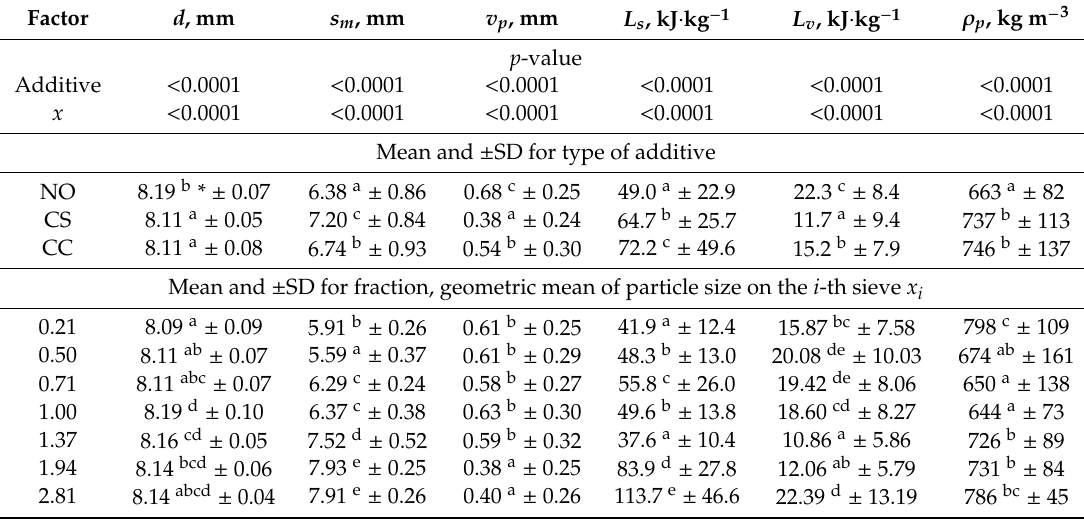
Table 1. Results of variance analyses, mean values (with three repetitions for each measurement setup), and SDs of pellet diameter, piston displacement at maximum agglomeration pressure, pellet shift in the die, specific compaction work, specific work for pellet shift in the die, and dry matter (DM) single pellet density for di ff erent types of additive and fraction particle size ( x